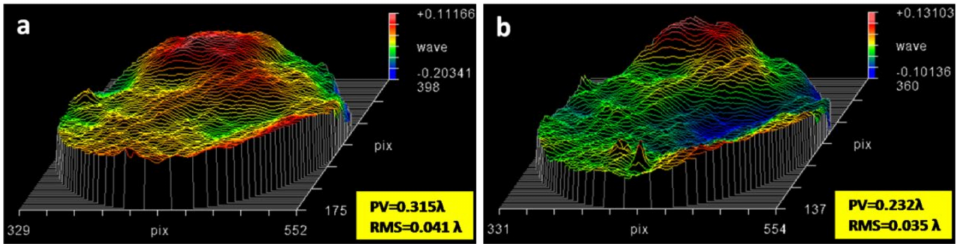
Figure 5. The wavefront error of Φ 200 mm PI membrane ( a ) before and ( b ) after coated with SiO 2 antireflective membrane on both